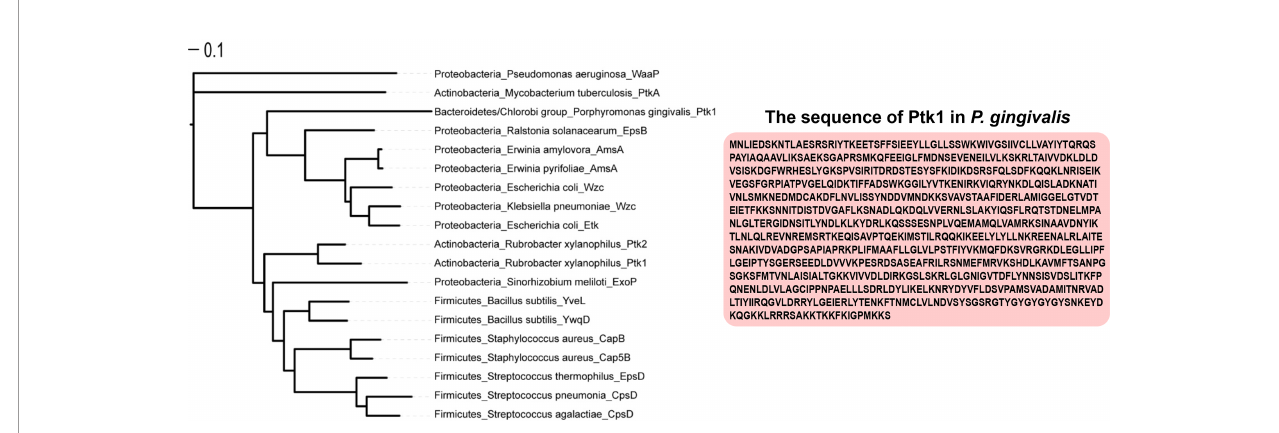
FIGURE 3 | Phylogenetic tree analysis of bacterial tyrosine kinase. Phylogenetic tree analysis of 19 bacterial BY kinases by the RAxML maximum likelihood method and visualization of the results with